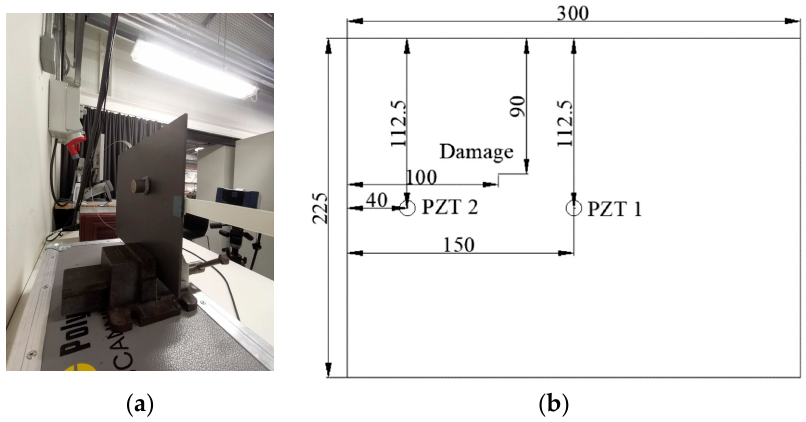
Figure 10. ( a ) Weighted blue tack and ( b ) schematic of the damage position.